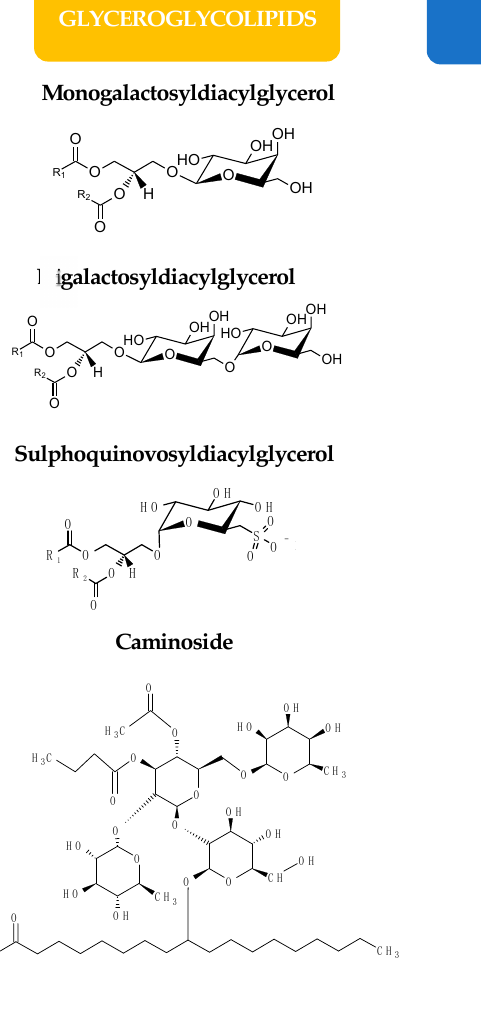
Figure 2. Cont . Figure 2.